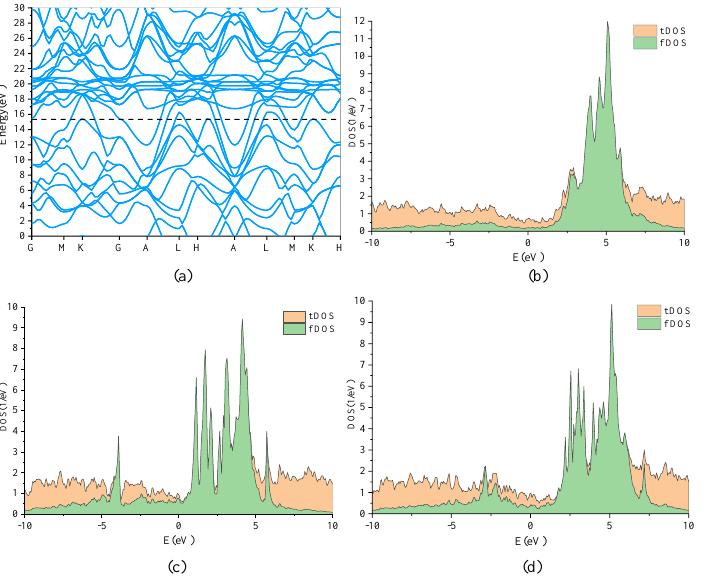
Figure 3. Spectral weight transfer induced by many-body corrections. ( a ) Electronic band structure and ( b ) density of states obtained by DFT calculations. tDOS and f DOS denote the spectral weight obtained by the imaginary part of respectively the lattice and f impurity Green function, correspond- ing to the spectral weight traced over all orbitals and traced over the f orbitals, respectively. In ( c , d ), we show the energy-resolved spectral weight, obtained respectively by the one-shot DFT+DMFT and the full-charge self-consistent DFT+DMFT+CSC. All calculations were performed in the P6/mmm phase of LaH 16 at 250 GPa.